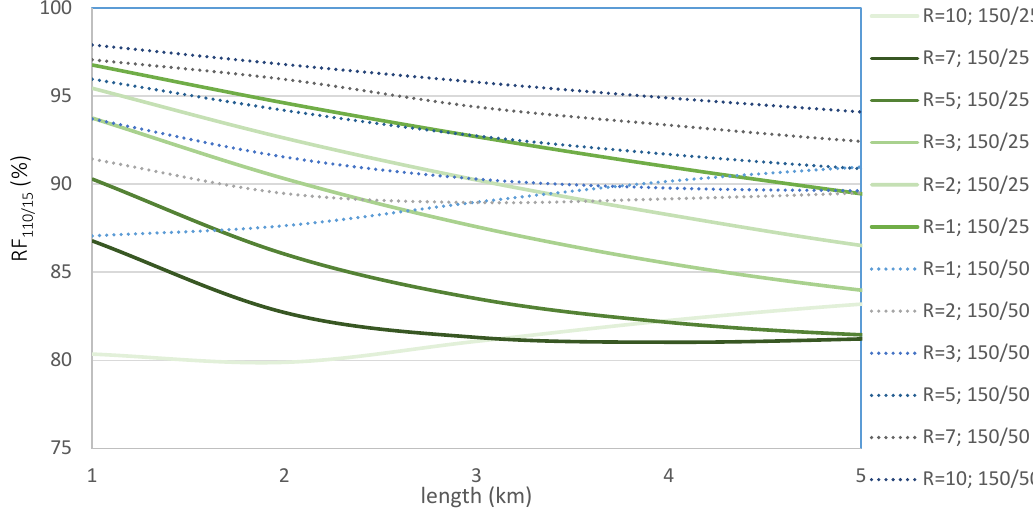
Figure 8. The idea of reverse self-current (capacitive) and reverse self-induced (capacitive) current.